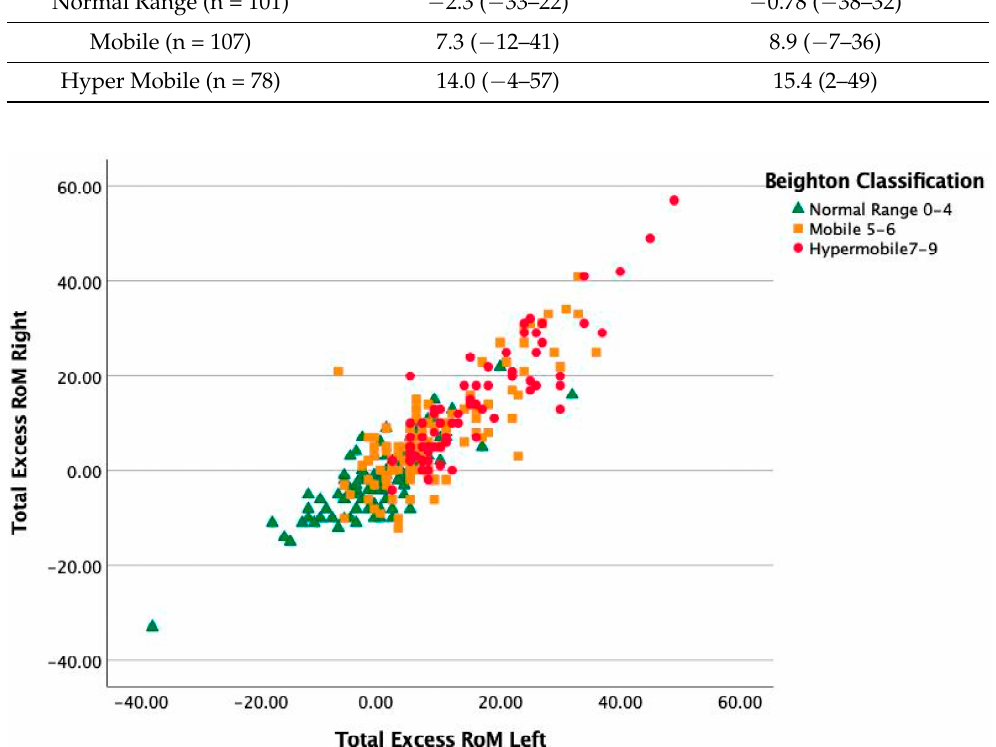
Figure 7. Excess range of motion. Note, there is a large overlap in the excess range of motion in the three Beighton classi fi cation groups.